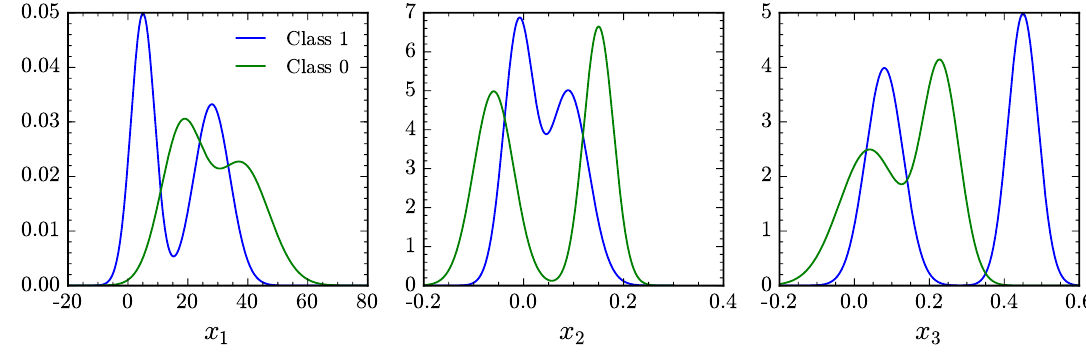
Figure 3 . Probability density functions for our toy model. The means and standard deviations of the individual modes are found in table 2.